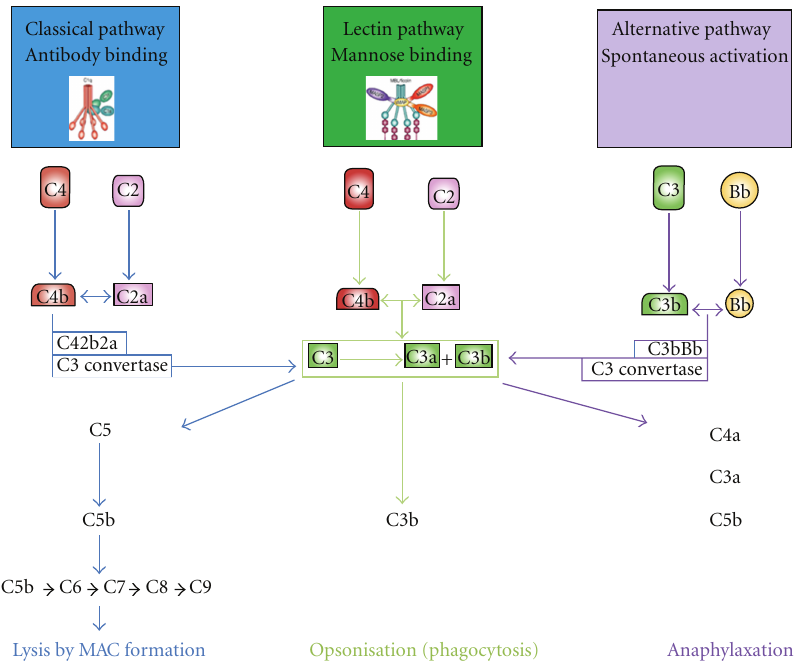
Figure 1: The complement system: the classical complement pathway involves a sequentially acting multistep cascade in which the complement components C1q, C1s, C1r, C4, C2, and C3 play important roles. C1r and C1s, the two serine protease proenzymes, along with C1q constitute C1, the first component of the classical pathway [25]. The activation of the C1 complex (C1q+C1s–C1r–C1r–C1s) subsequently activates the complement through the cleavage of C4 and C2 to yield the central molecule C3 convertase that cleaves C3, leading to the activation of the C2–C9 components and thus the formation of the terminal membrane attack complex (MAC) [26]. The MAC binds to cell membranes and facilitates cell lysis. The alternative pathway is initiated by low-level activation of C3 via its hydrolysis (C3b) and activated factor B. The activated C3b binds factor B that is cleaved by factor D to form C3 convertase. The main di ff erence between classical and alternative pathway is that the initiation of alternative pathways is not dependent on the presence of immune complexes. The lectin pathway is activated following the recognition and binding of pathogen-associated molecular patterns (PAMPs) by mannose-binding lectin (MBL) [27]. The binding of MBL to repetitive carbohydrate patterns on pathogen surfaces has the potential to activate the lectin pathway through the MBL-associated serine protease (MASP), designated as MASP-2, that in turn leads to the activation of complement components C4, C2, and C3. The association of MBL-MASP complex of the lectin pathway is analogous to C1 complex of the classical complement